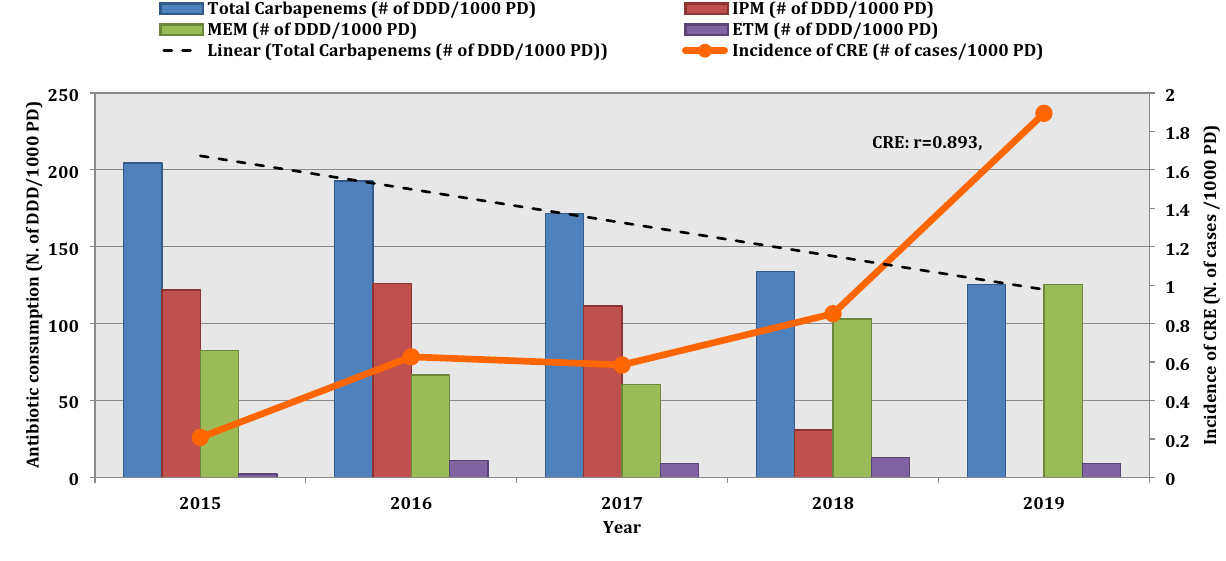
Figure 1. Temporal trend of carbapenem-resistant Enterobacterales acquisition incidence density and carbapenem consumption intensity from 2015 to 2019. DDD defined daily dose, ETM ertapenem, IPM imipenem, MEM